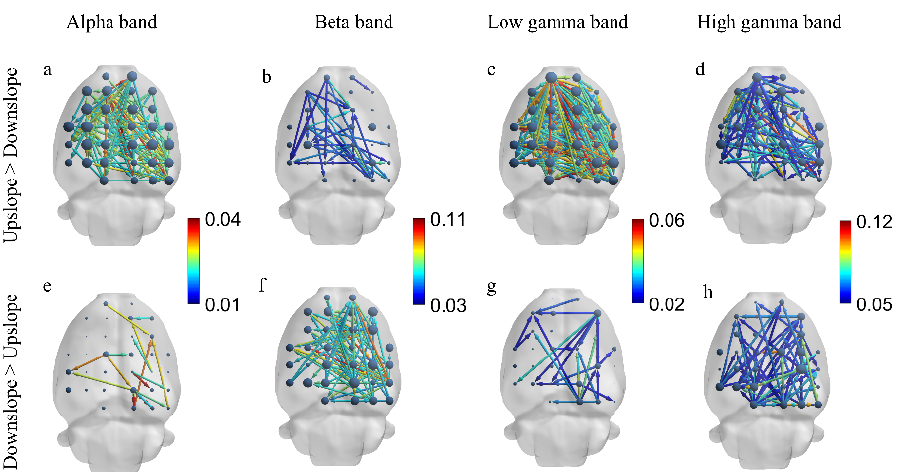
Figure 5. Difference in brain functional directed connectivity between two locomotion states in four sub-bands. ( a ) Increased connectivity in upslope locomotion relative to that in downslope locomotion in the alpha band (7–13 Hz). ( b ) Increased connectivity in upslope locomotion relative to that in downslope locomotion in the beta band (13–30 Hz). ( c ) Increased connectivity in upslope locomotion relative to that in downslope locomotion in the low gamma band (30–50 Hz). ( d ) Increased connectivity in upslope locomotion relative to that in downslope locomotion in the high gamma band (50–100 Hz). ( e ) Increased connectivity in the downslope relative to that in upslope locomotion in the alpha band (7–13 Hz). ( f ) Increased connectivity in downslope locomotion relative to that in upslope locomotion in the beta band (13–30 Hz). ( g ) Increased connectivity in downslope locomotion relative to that in upslope locomotion in the low gamma band (30–50 Hz). ( h ) Increased connectivity in downslope locomotion relative to that in upslope locomotion in the high gamma band (50–100 Hz). Threshold set to 50% of the strongest connection (i.e., preserving those connections exceeding 50% of the strongest connection). The node size is the degree, and the edge color denotes the connection